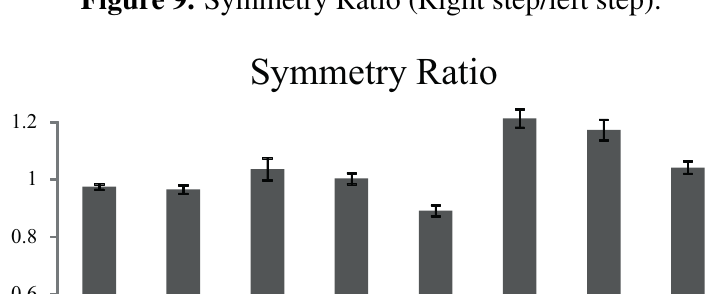
Figure 9. Symmetry Ratio (Right step/left